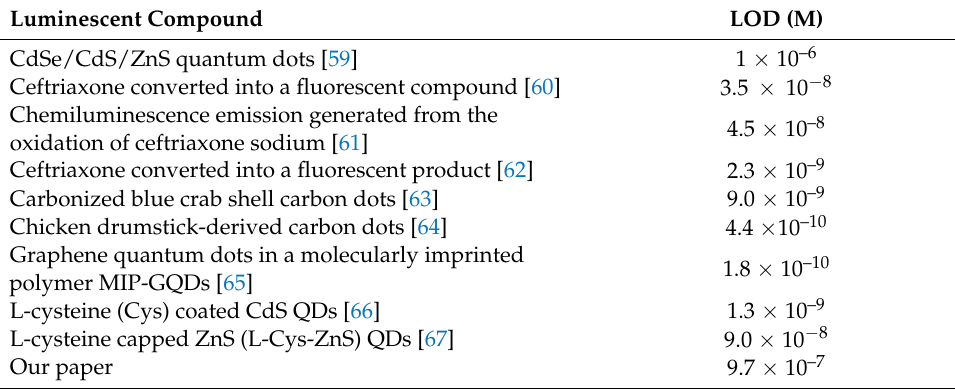
Table 4. LOD values of ceftriaxone detection for various luminescent nanomaterials/compounds reported in the literature.